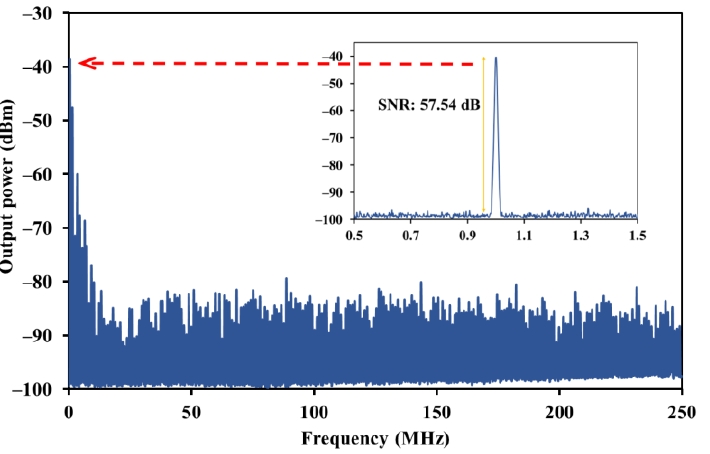
Figure 9. RF frequency spectrum with a 250 MHz span, signal-to-noise ratio (SNR) of 57.54 dB (in-